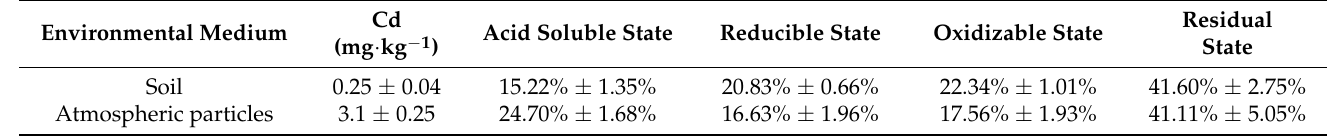
Table 1. Cd concentration and chemical state distribution of Cd in the soil and atmospheric particles.